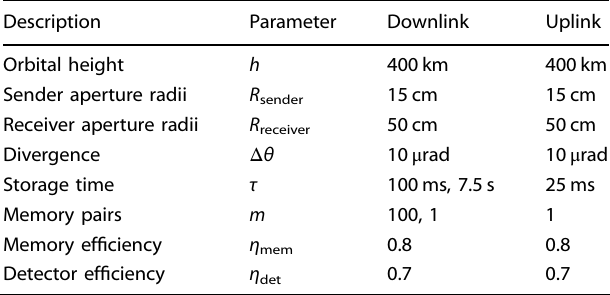
Table 1. Parameters used in MA-QKD